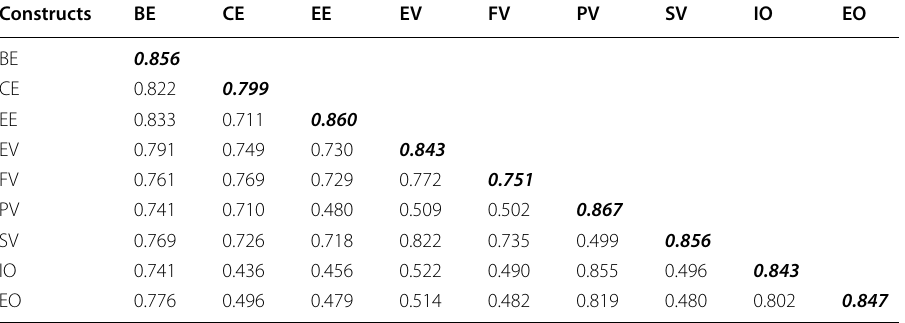
* Diagonal items in italics show the square root of the AVE. Off-diagonal items show the correlations between constructs